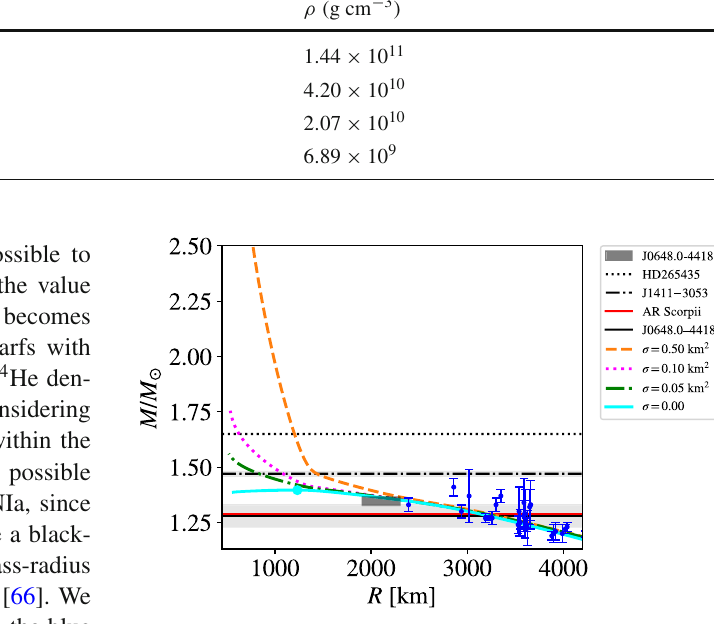
Fig. 1 Mass radius relationship for white dwarfs with different σ parameters and considering a star made of Helium. Four values of σ were considered. For σ = 0 . 0, the theory represents General Rela- tivity. The black-shaded region indicates the observed mass-radius of ZTFJ1901+1458, this region and mass-radius are taken from Ref. [66]. The black line and shaded region are 1 . 28 ± 0 . 05 M (cid:2) corresponding to RX J0648.0-4418 [83]. The red line represents the upper limit of the compact object in AR Scorpii [84]. The black dot-dashed line with shaded region is the binary system with total mass of 1 . 47 ± 0 . 01 M (cid:2) from Ref. [60] and the black dotted line is the binary system with a total mass of 1 . 65 ± 0 . 25 M (cid:2) from Ref. [62]. The blue circles with error bars represent the observational data of a sample of massive WDs taken from Refs.